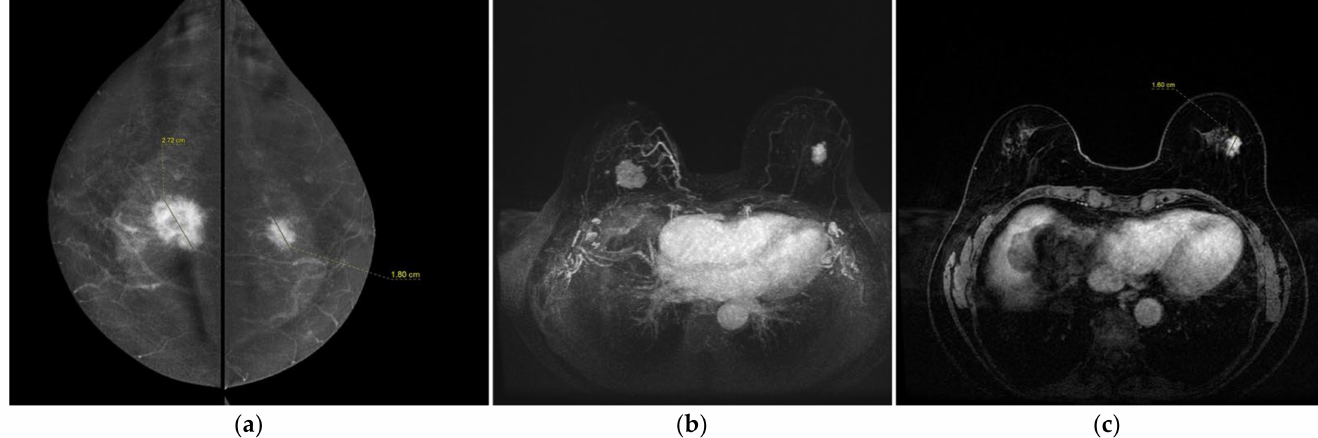
Figure 2. A 74-year-old women with synchronous bilateral breast cancer. Patient performs mam- mography and ultrasound examinations because a palpable mass in the upper quadrant of the right breast. ( a ) CESM CC views show an irregular-enhanced mass in the right breast and an irregular- enhanced mass in the left breast. They were an invasive ductal carcinoma in the right breast (27 mm in size) and an invasive lobular carcinoma in the left (18 mm in size). ( b ) BMR, axial MIP (Maximum intensity projection) reconstruction shows bilateral breast cancer. Note the similarities with the CESM images (morphology of the masses and increased local vascularity in the right breast). ( c ) BMR, first post-contrast axial T1-weighted fat saturation dynamic axial sequence (Vibrant). Measurements of the lesions show good agreement with CESM (16 mm).